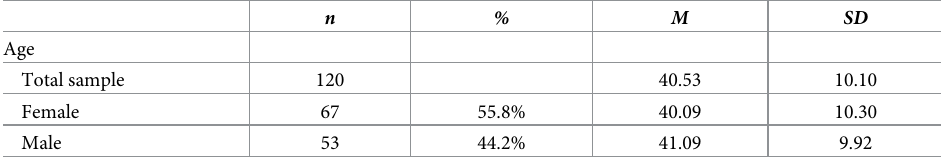
Table 7. Demographics of the participants in the emotional problem-solving study.